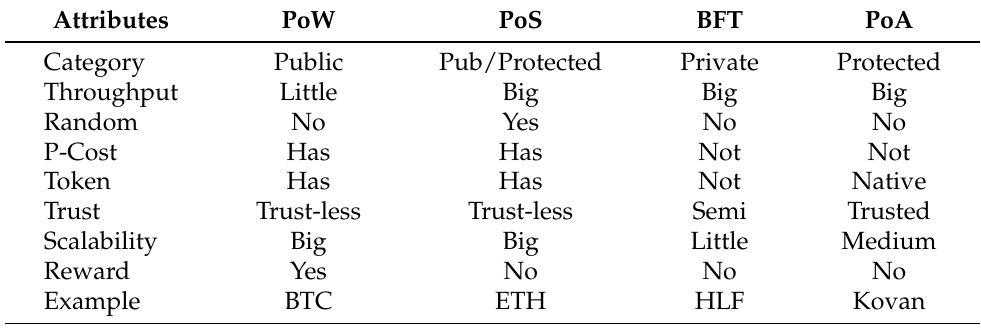
Table 2. A comparison of several widely used consensus techniques for BC technology.